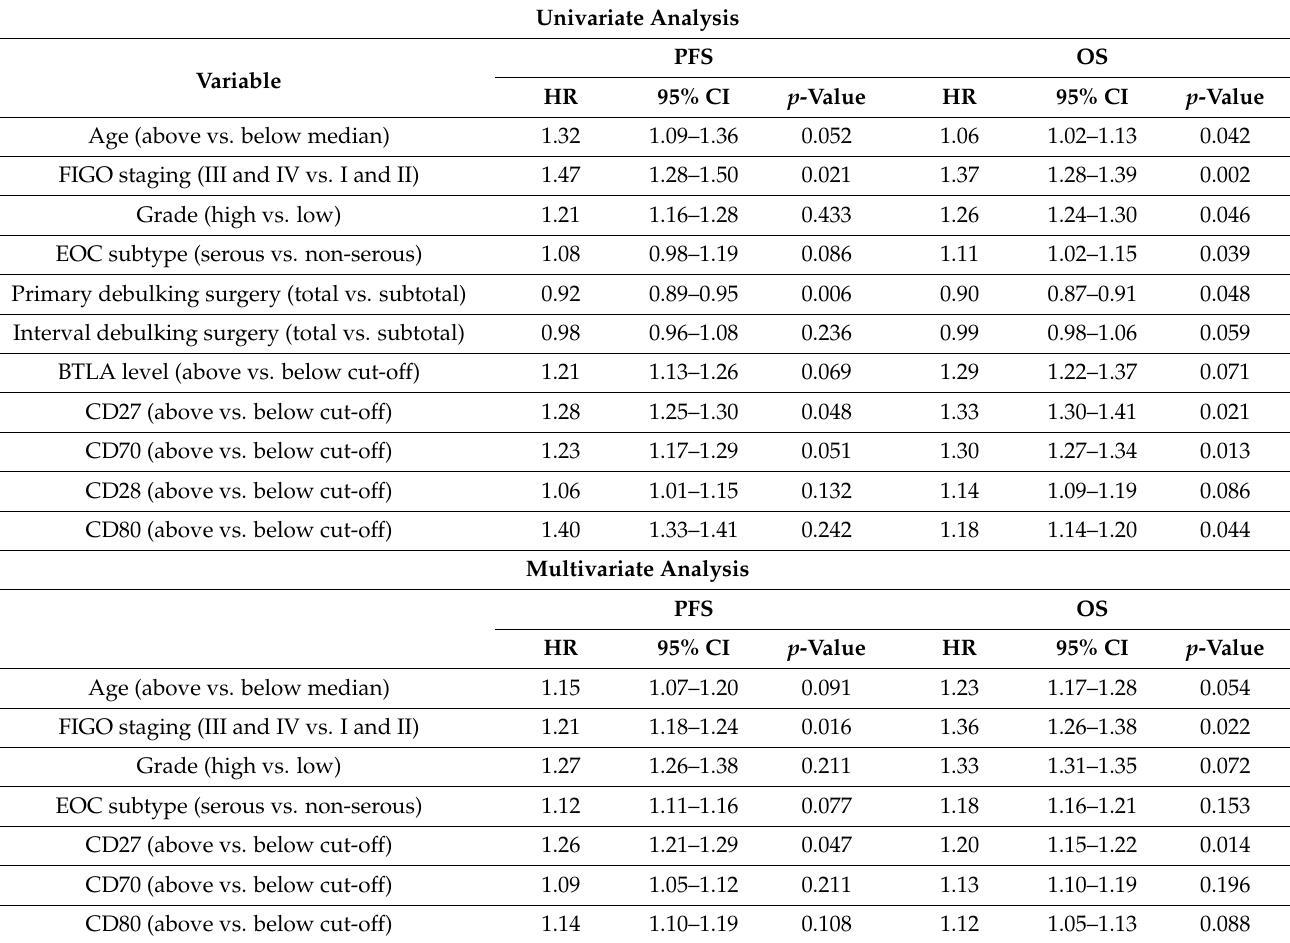
Table 12. Univariate and multivariate Cox regression model for serum concentrations of the pro- teins studied.